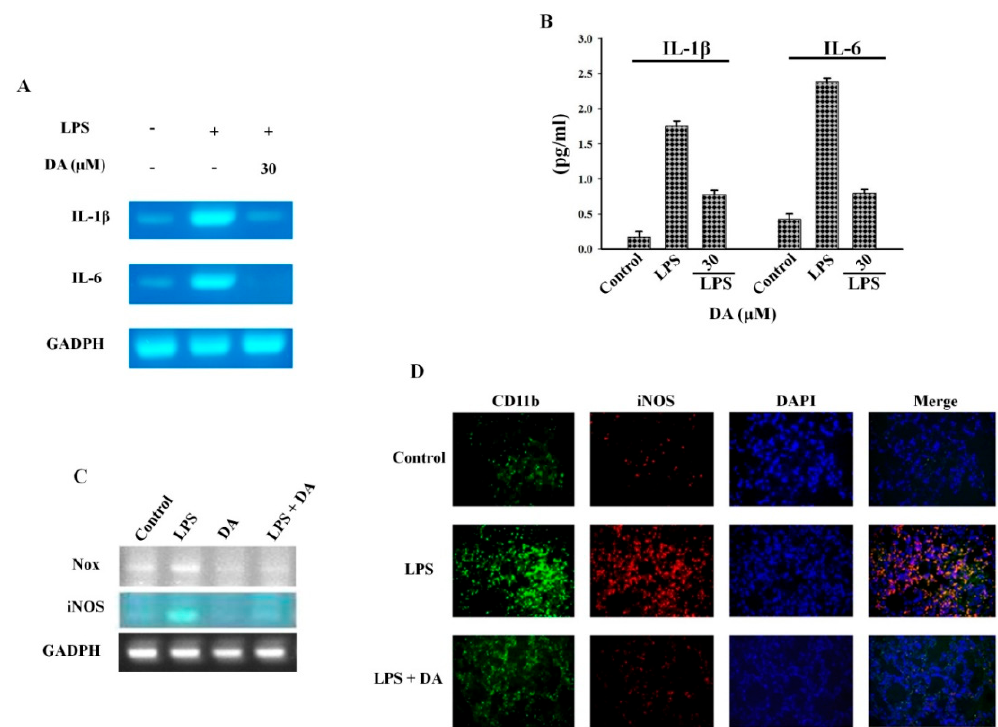
Figure 3. DA inhibits macrophage polarization. ( A ) mRNA levels of IL-1 β and IL-6 were analyzed through RT-PCR after incubating the cells with LPS and 30 μ M DA; ( B ) the exogenous secretion of IL-1 β and IL-6 by LPS-stimulated cells was analyzed through ELISA. LPS stimulated the secretion of IL-1 β and IL-6, which was significantly blocked by DA; ( C ) mRNA levels of NOX and iNOS in cells incubated with LPS with or without DA were analyzed through RT-PCR. ( D ) RAW 264.7 cells were seeded onto a 4-well chamber slide and cultured until 70% confluency was reached. The cells were then incubated with LPS with or without DA for the indicated amounts of time. Cells were fixed with 3.7% formaldehyde and then permeabilized by incubating them with 0.1% Triton X-100 for 4 min. Afterwards, the cells were incubated with anti-CD11b or anti-iNOS antibodies overnight and then incubated with FITC- or Alexa Flour 594-conjugated antibodies. Finally, the cells were incubated with DAPI mounting medium for 5–10 min and analyzed through confocal microscopy.